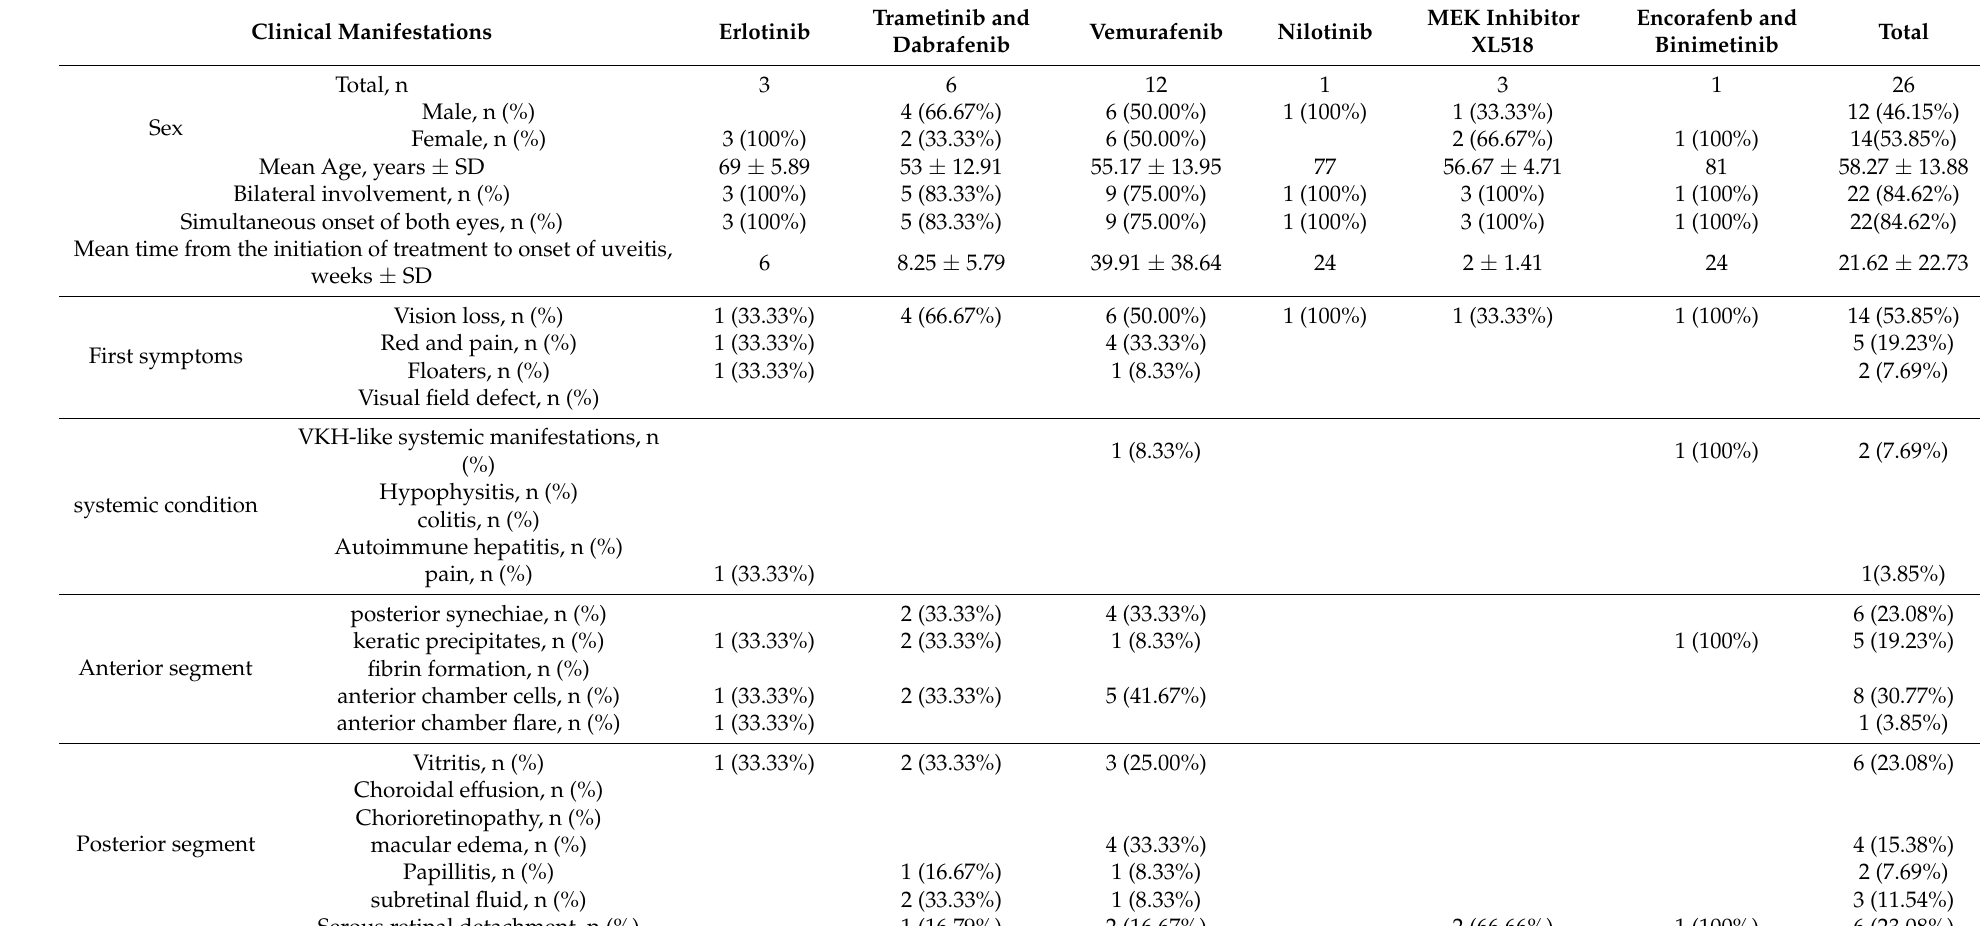
Table 3. Clinical manifestations of uveitis caused by specific targeted